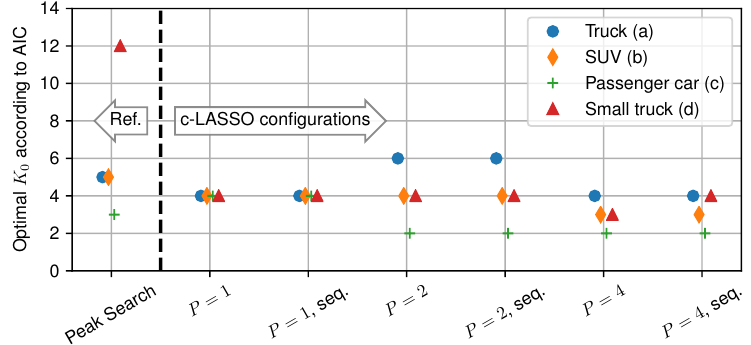
Figure 11. Optimal number of clusters K 0 for all presented estimation basis and measurements. To the left of the separator, peak search is given as reference. On the right, different c-LASSO configurations are shown. The numbering is consistent with Figure